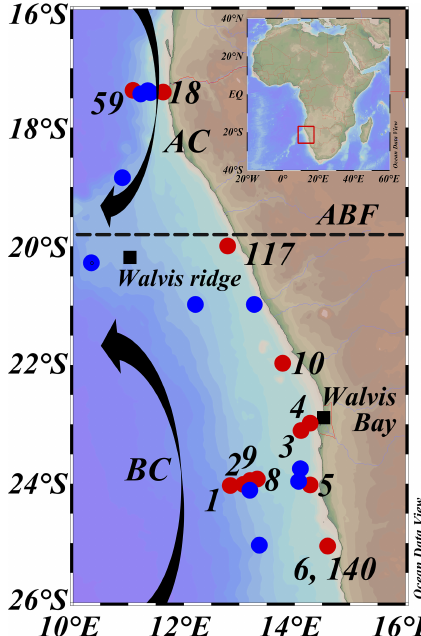
Figure 2. Map of sampled stations during expeditions 64PE449 (27 January–14 February 2019) and 64PE450 (15 February– 10 March 2019), with station dots color coded according to sam- pling activities, CTD casts and nutrients (blue), and CTD casts and nutrients plus DNA and SPM sampling (red). Numbers indicate sta- tion labels of red dots. Station labels and coordinates of blue dots are given in Table S1. AC: Angolan current; BC: Benguela current; ABF: Angolan Benguela Front ( ∼ 19.8 ◦ S). Maps were created in ODV using the ETOP01_2min global tiles map (Schlitzer, R, Ocean Data View, https://odv.awi.de, last access: 12 June 2021).